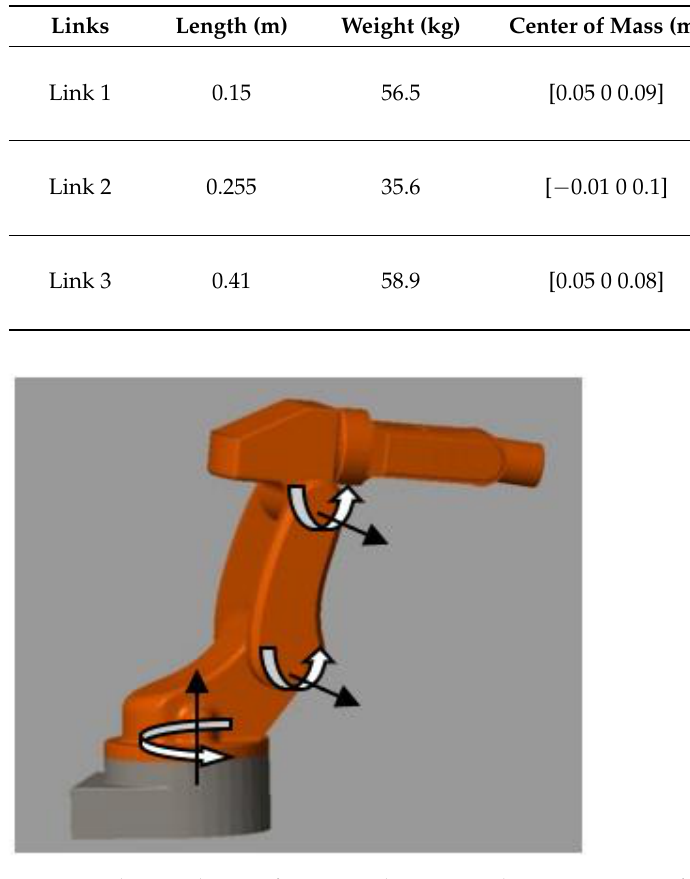
Figure 1. The simulation of 3-DOF Robot Manipulator in MATLAB/Simulink.